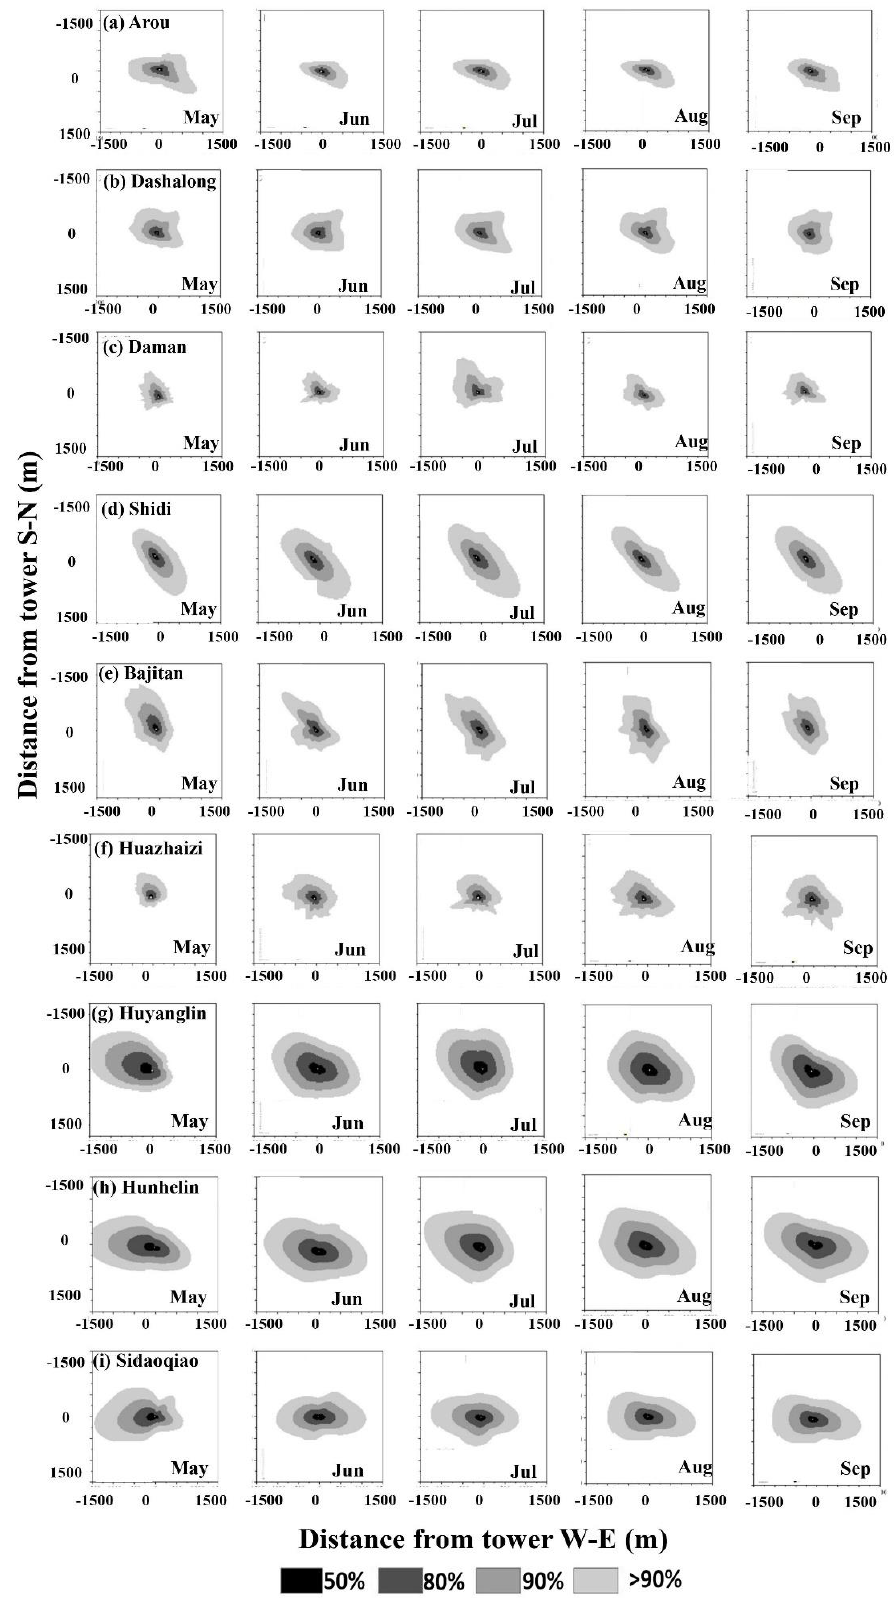
Figure 5. Climate footprint of field GPP from May to September in 2014. The gray level describes the cumulative weight contribution to the footprint.